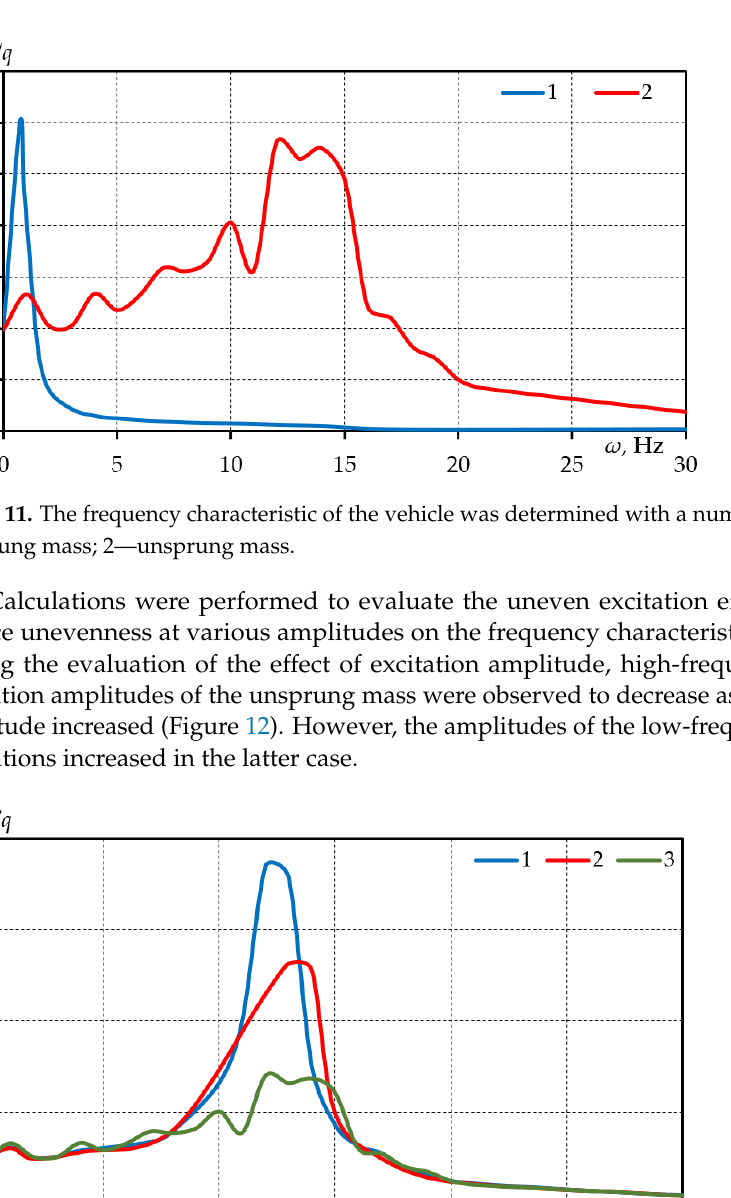
Figure 10. Modeling of suspension characteristics: ( a ) — elastic characteristic; ( b ) — damping characteristic of the damper; 1 — typical characteristic; 2 — simulated characteristic; 3 — inflection zone refinement.